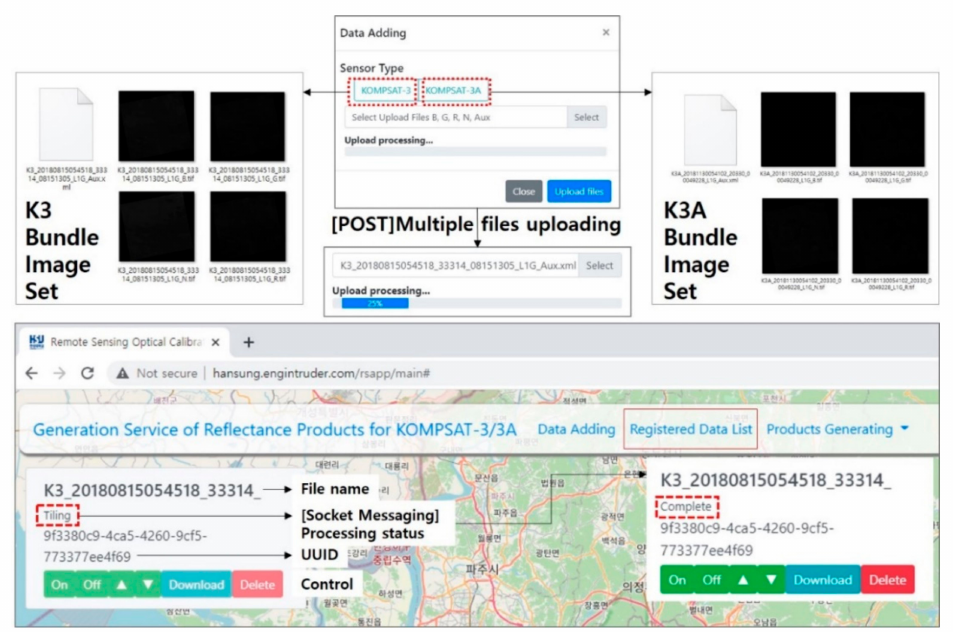
Figure 6. Registration of KOMPSAT-3/3A bundle image set in the SaaS and internal tiling process.